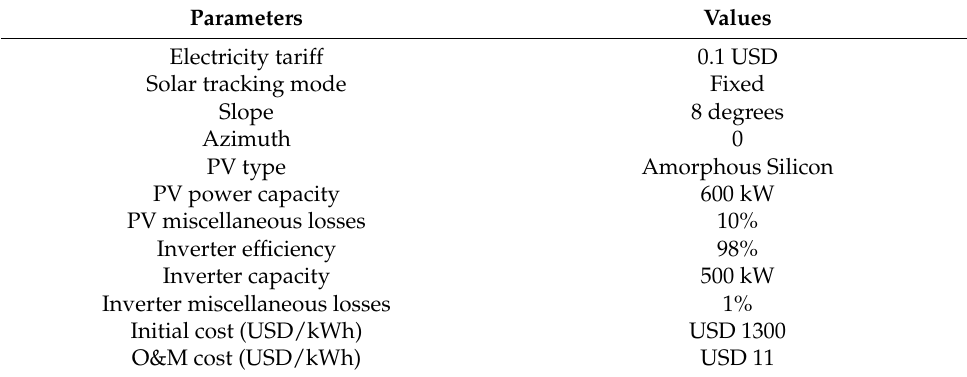
Table 3. RETScreen inputs for 600 kW